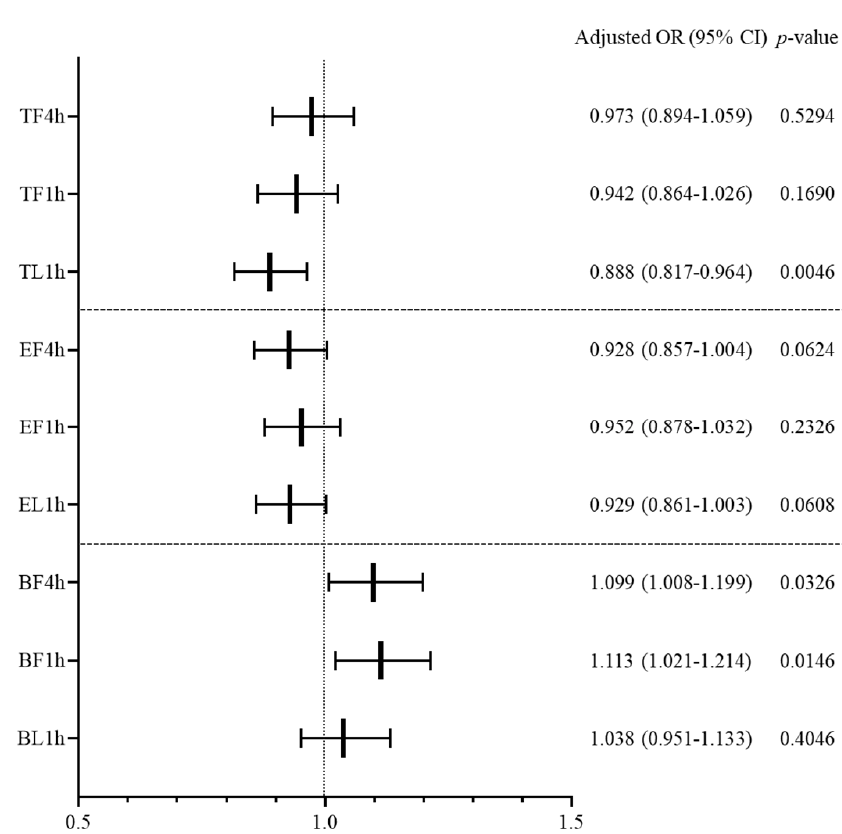
Figure 4. Influence of overcrowding in the emergency department on the occurrence of return visit within 72 h. OR, odds ratio; CI, confidence interval; TF4h, total patients during first 4 h; TF1h, total patients during first 1 h; TL1h, total patients during last 1 h; EF4h, evaluating patients during first 4 h; EF1h, evaluating patients during first 1 h; EL1h, evaluating patients during last 1 h; BF4h,